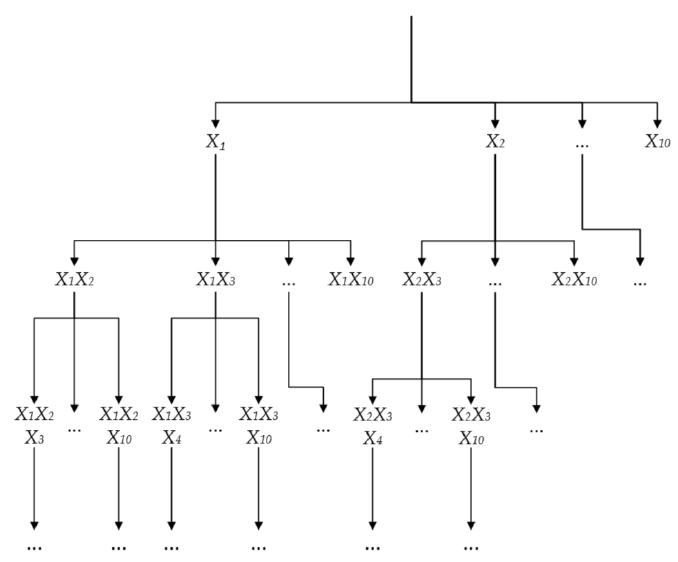
Figure 10. Contour fragment search tree.